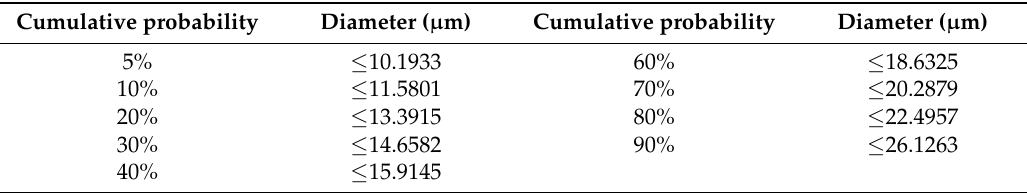
Table 2. Cumulative probability of particles versus diameters.